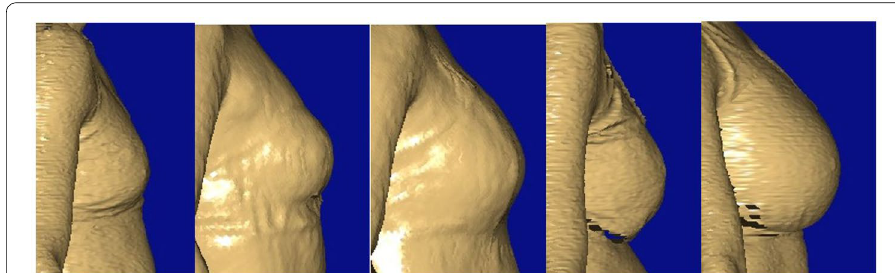
Fig. 10 Examples of bust fullness, from left: very small, small, average, full, very full